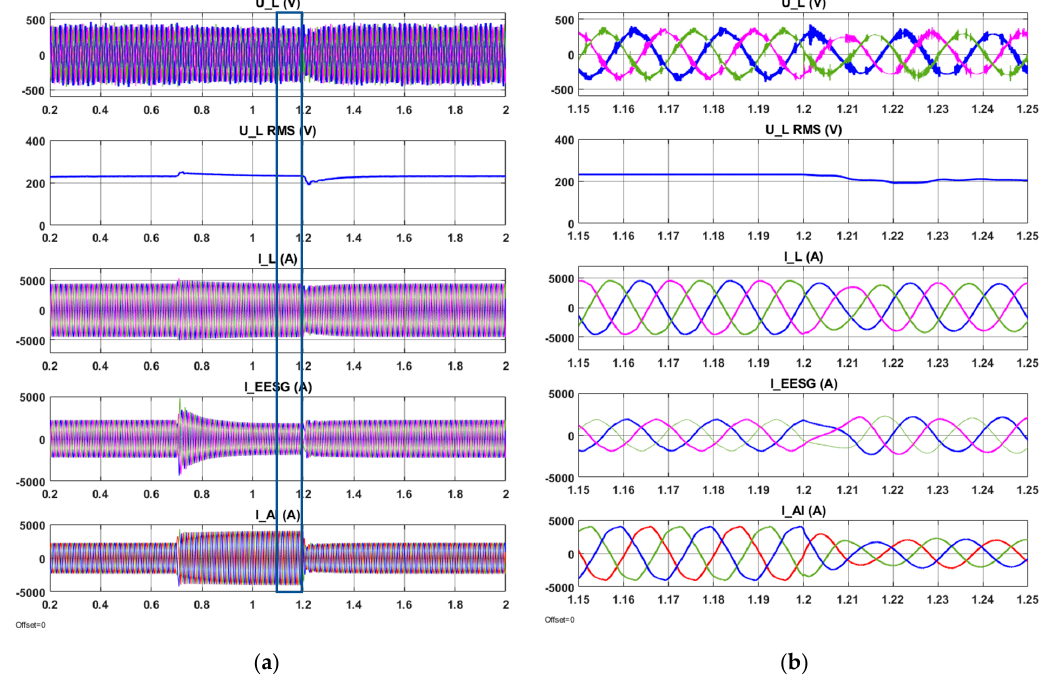
Figure 19. Electromagnetic processes in the operation of the DG–SG mechatronic system during ( a ) change from k = 0.5 to k = 1 and then back to k = 0.5; ( b ) in the interval of time 1.15–1.25 s changing from k = 1 to k = 0.5.